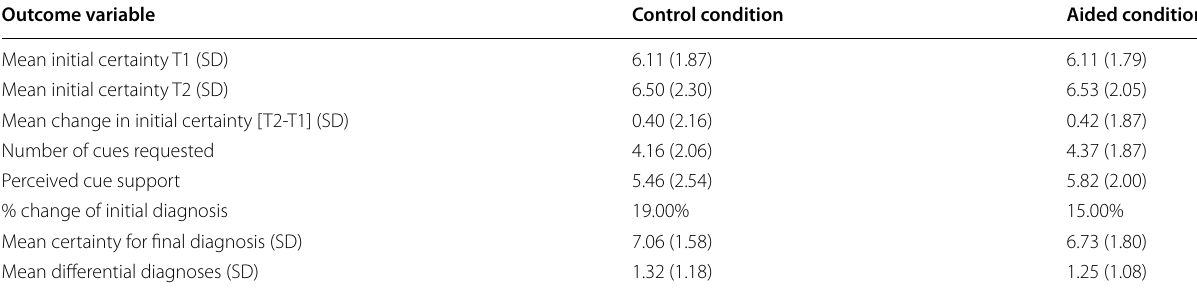
Initial certainty T2 is the certainty in the initial diagnosis measured after participants requested and received additional cues and before they provided their final diagnosis. Change in initial certainty refers to the difference between the second and the first measurements of initial certainty and was on average positive